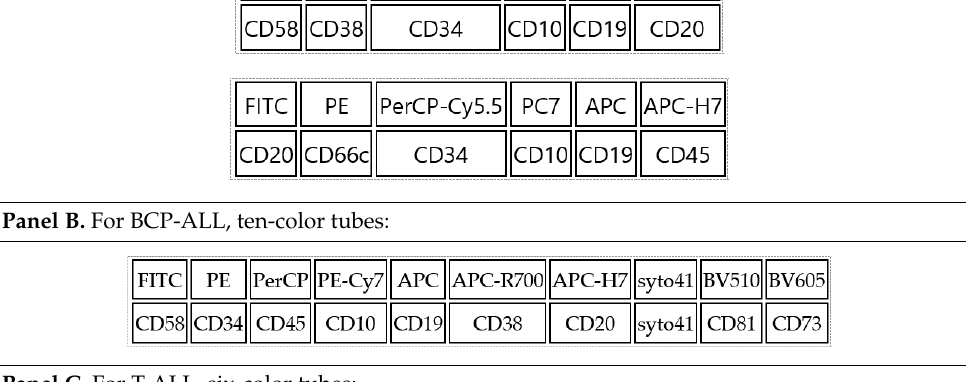
Panel C. For T-ALL, six-color tubes: